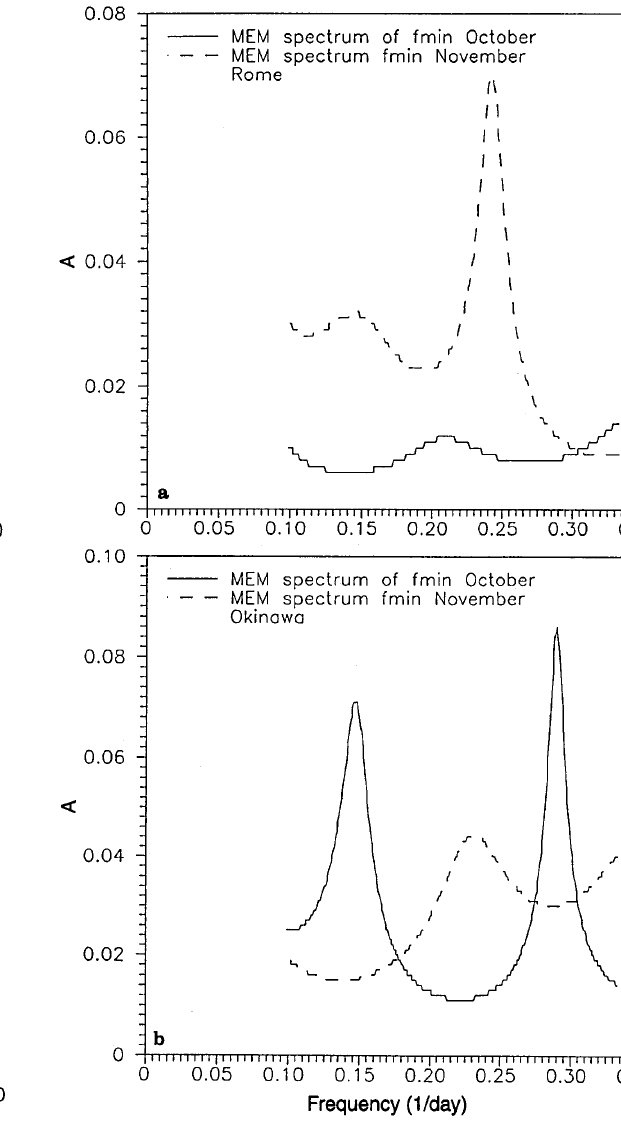
Fig. 2. MEM spectra in the period interval 3–10 days obtained separately for October ( solid line ) and November ( dashed line ) for stations: a Rome, and